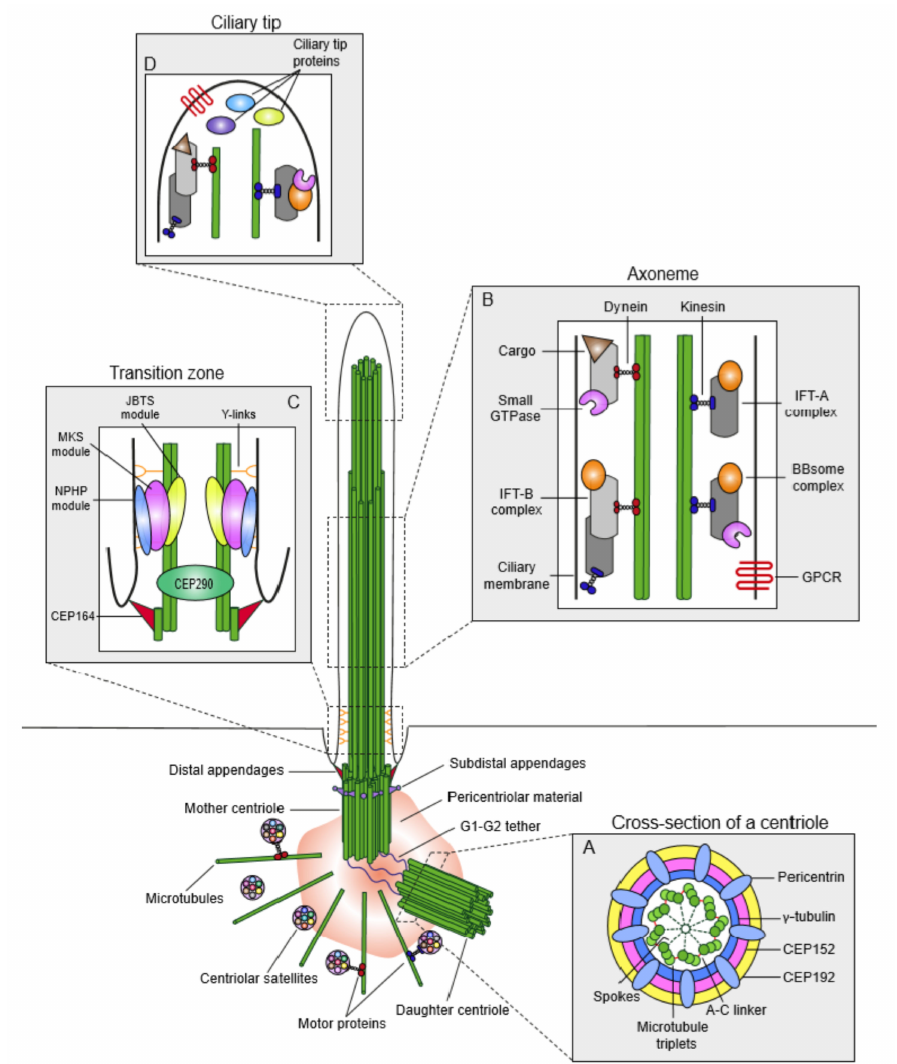
Figure 1. Overview of the anatomy of the centrosome / cilium complex and its sub-compartments. The centrosome / cilium complex is composed of the centrosome, the primary cilium and the centriolar